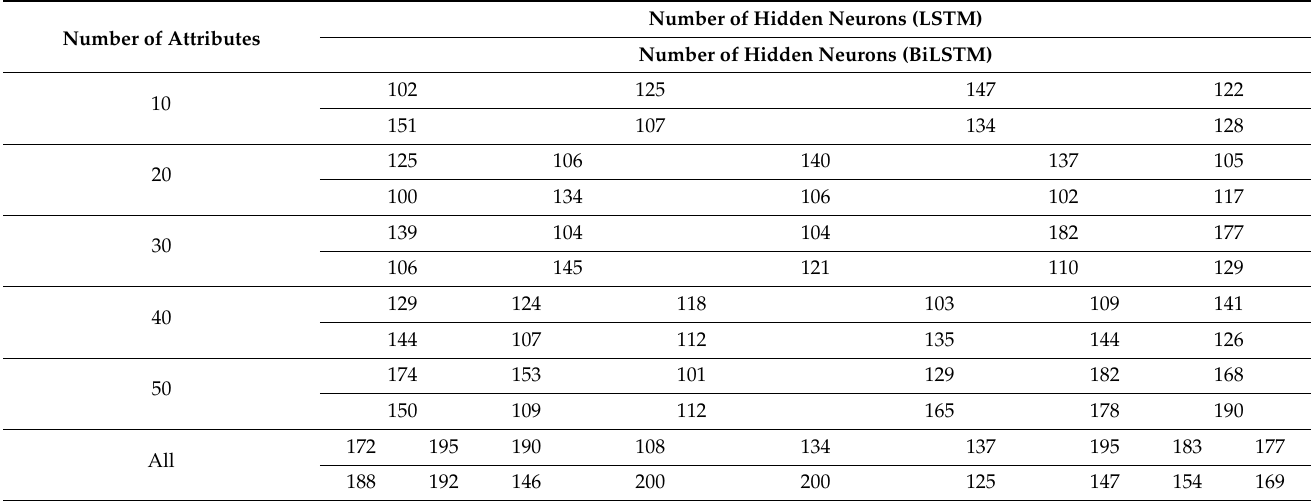
Table 5. Optimized number of hidden neurons for cancer prediction. (Illustrations by the authors).